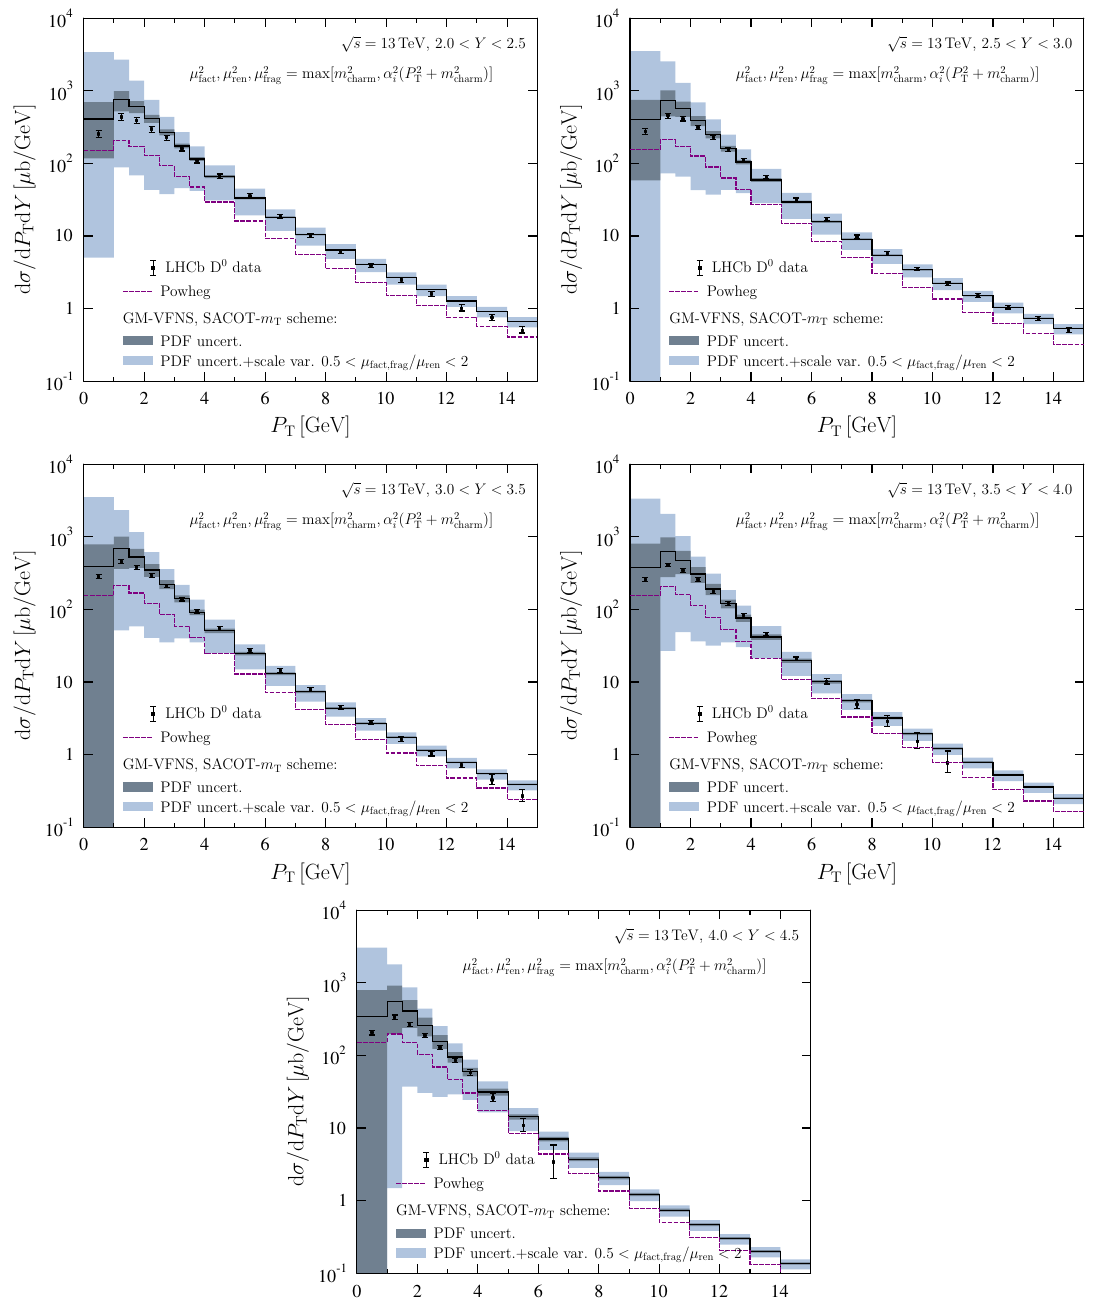
p Figure 7 . A comparison of the LHCb s = 13 TeV D 0 + D 0 data [2] with the GM-VFNS and Powheg calculations. The black lines indicate the central GM-VFNS results, the PDF uncertainty is shown as darker band, and the light-blue band is the PDF uncertainty and scale variation added in quadrature. The purple dashed line is the central result from Powheg